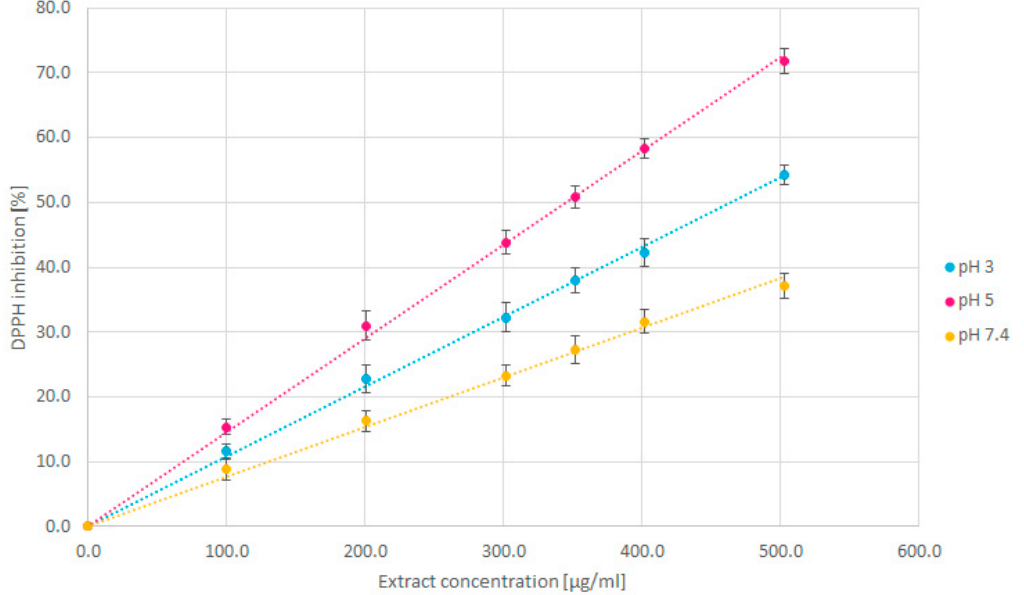
Figure 1. DPPH • reduction percentage of aqueous Moringa extracts at various pH values after 30 minutes of reaction at 25 °C.